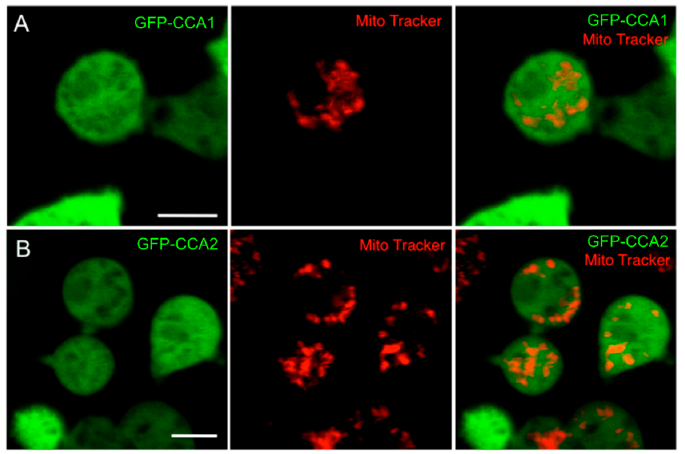
Figure 2. Subcellular localization of CCA1 and CCA2 enzymes. Full length CCA1 and CCA2 enzymes fused to GFP (( A ): GFP-CCA1; ( B ): GFP-CCA2) were overexpressed in wild-type Dictyostelium cells and show a cytosolic distribution but no specific enrichment within mitochondria (red, stained with MitoTrackerRed). Size bar represents 5 µm.